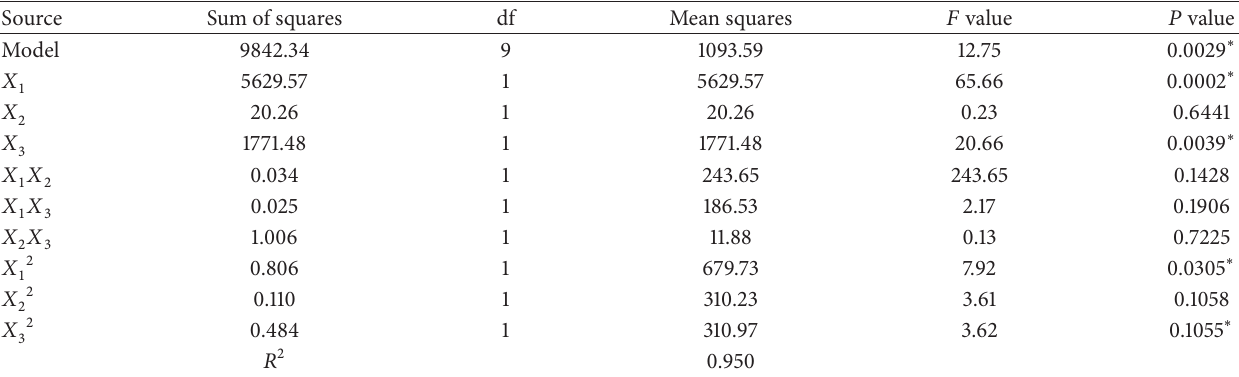
Table 3: ANOVA parameters for peak